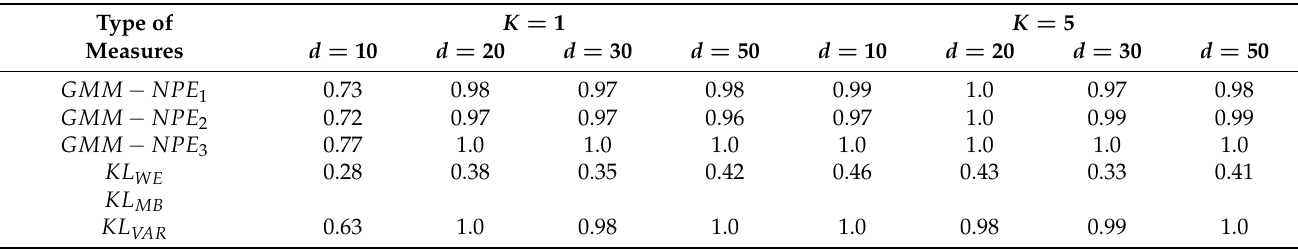
Table 3. Results in the form of recognition accuracy, obtained on the synthetic data: l = 1, t ∈ [ − 3,5 ] , N = 800, M = 200, m 1 , m 2 = 0.